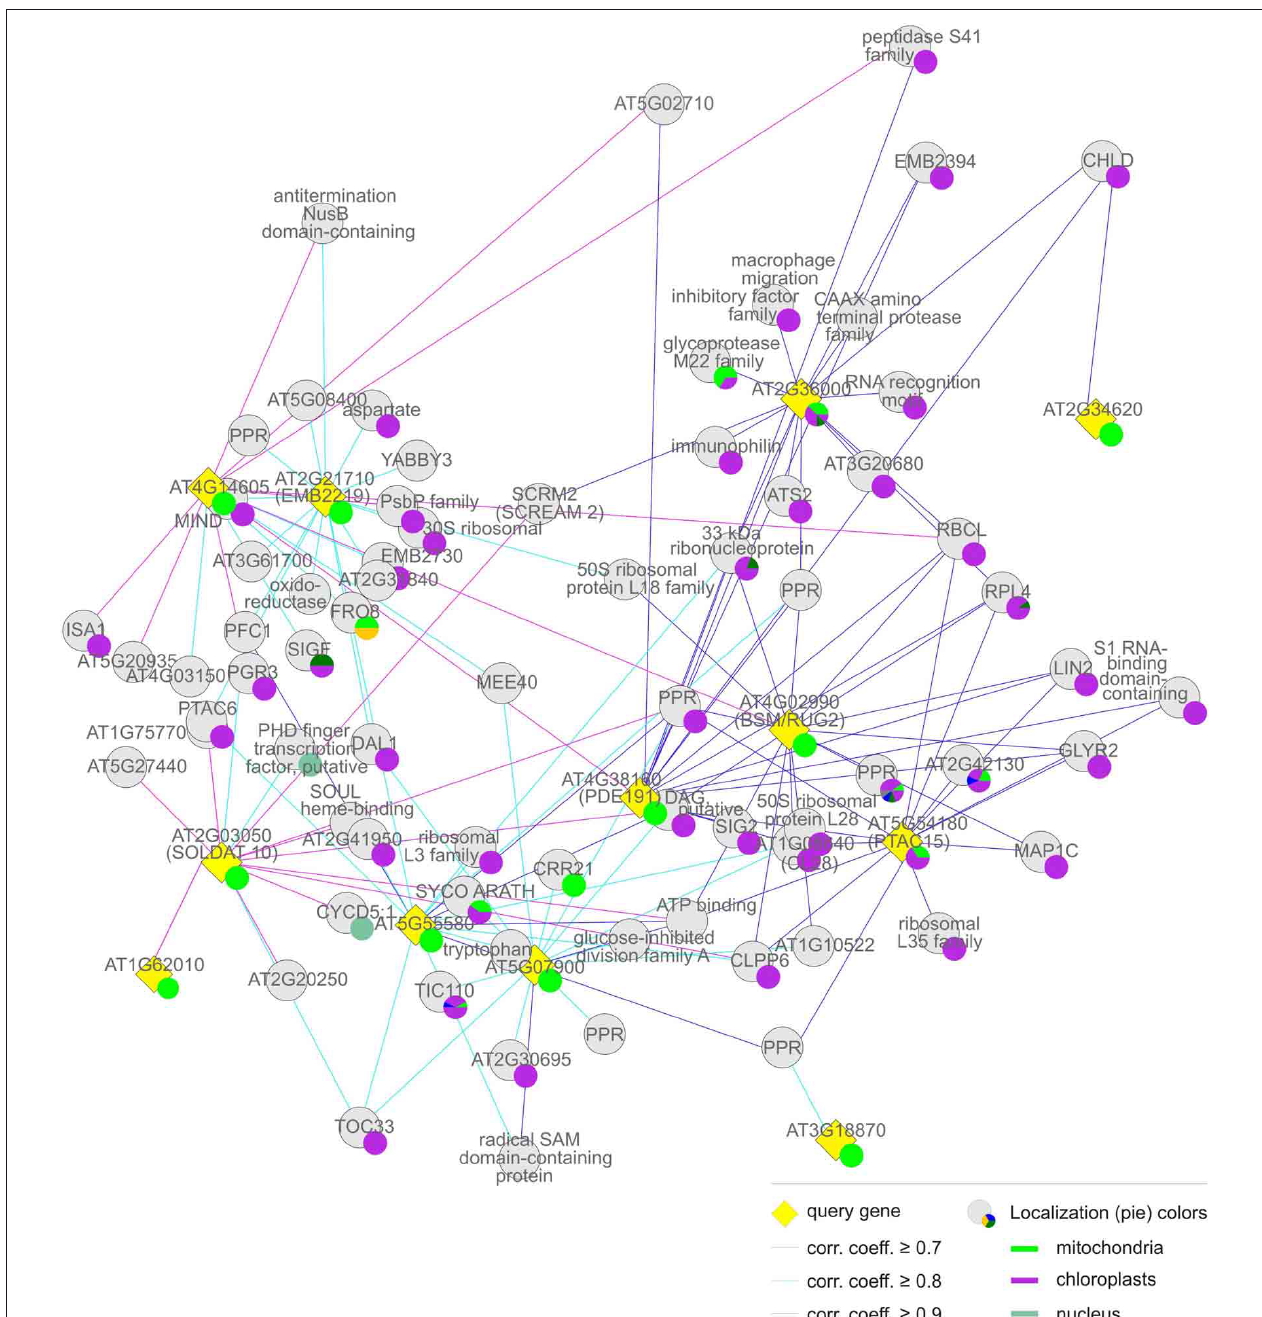
FIGURE 4 | Group (i), the “chloroplast” cluster. Coregulation gene network derived from condition-independent co-expression analysis using the CORrelation NETworks tool (CORNET2.0; https://bioinfor matics.psb.ugent.be/cornet; De Bodt et al., 2012). Only strong